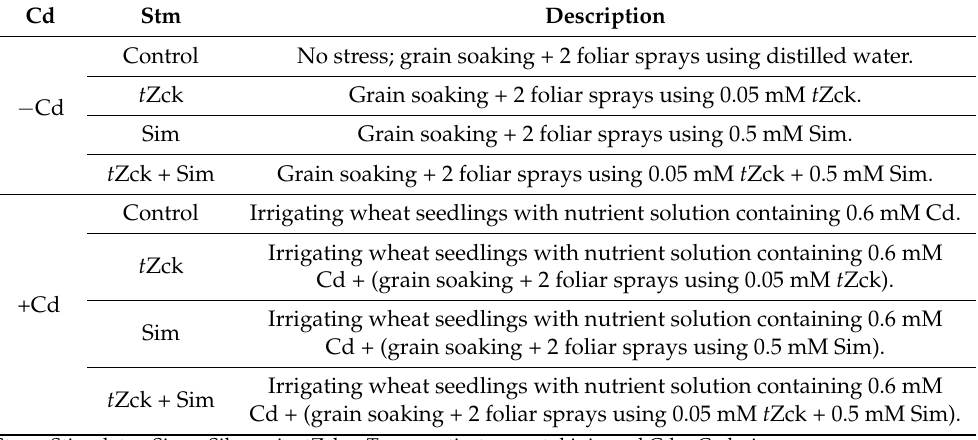
Table 1. Descriptions of study